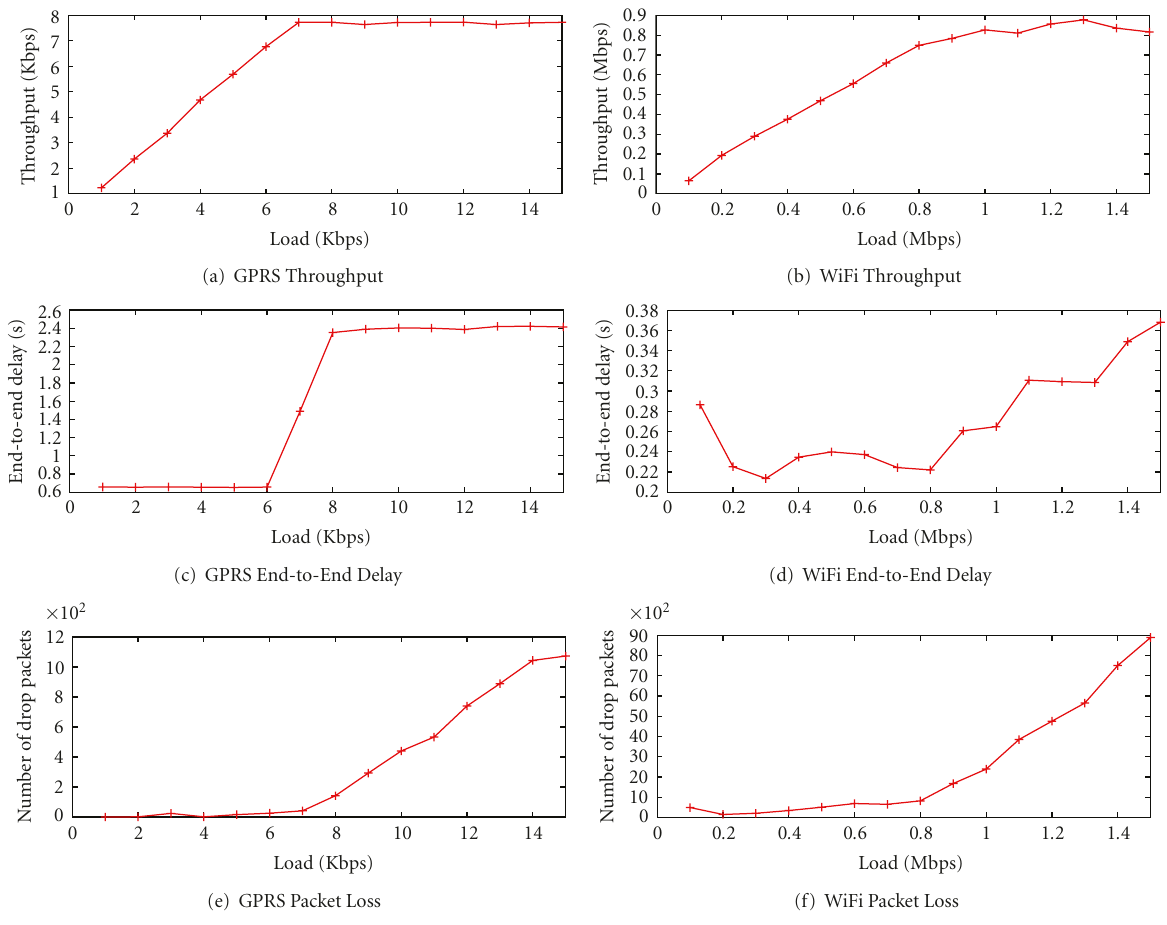
Figure 18: GPRS and WiFi network performance in coexistence